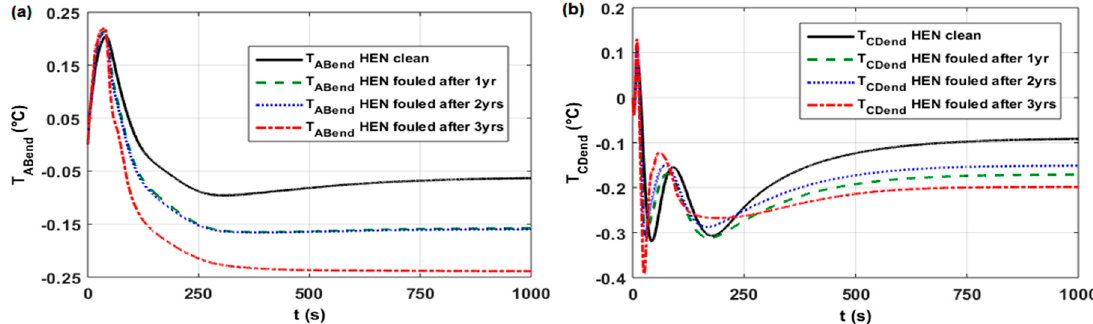
Figure 13. Open-loop responses of the HEN models (( a )—the end temperature T ABend and ( b )—the end temperature T CDend , after parallel branches) to +10% step change in tube-side flowrate of branch A and C , and to − 10% step change in flowrate of branch B and D .